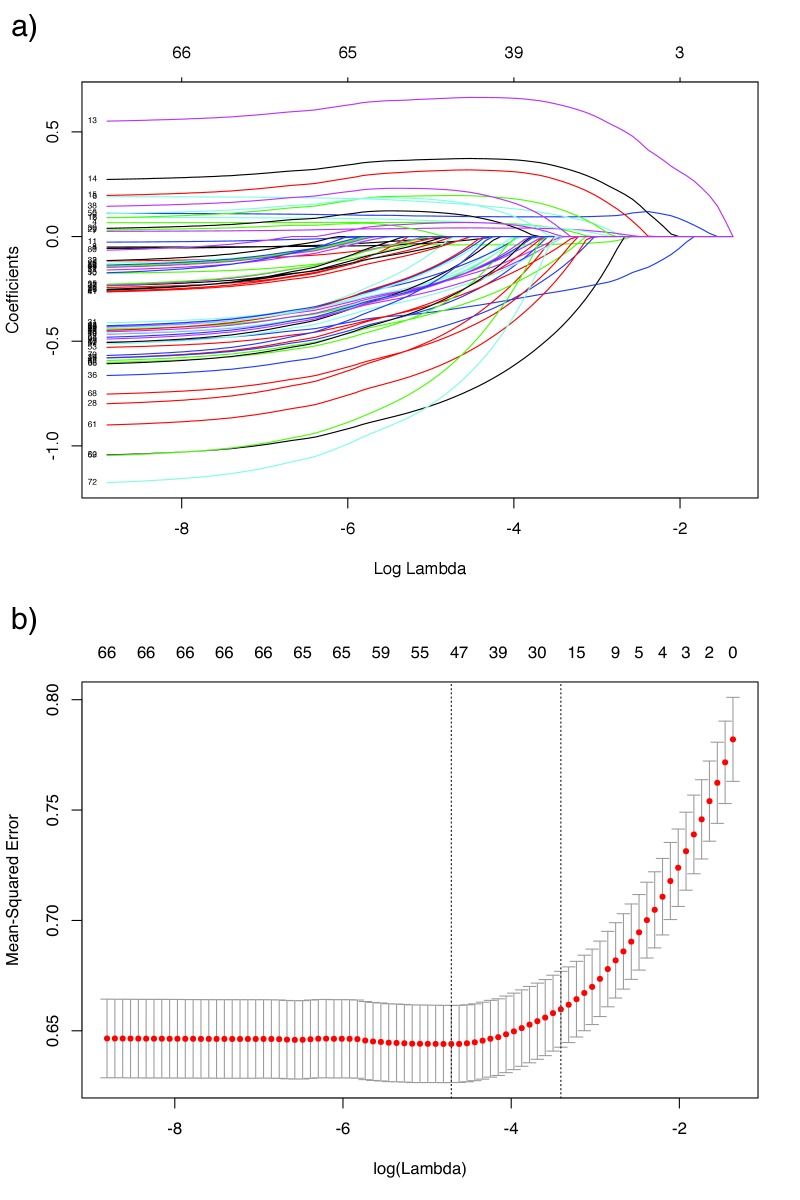
Lasso regression plots for lineage effects.Panel a) shows the value of each predictor on the y-axis for different values of the ℓ1 penalty λ on the x-axis, which increases from left to right. The labels along the top are the number of predictors remaining in the model for each λ. Panel b) shows the results of leave-one-out cross validation on the mean-squared error, along the same x-scale. The λ at minimum error is shown by the left dashed line, and the λ within one standard error is shown by the right dashed line.